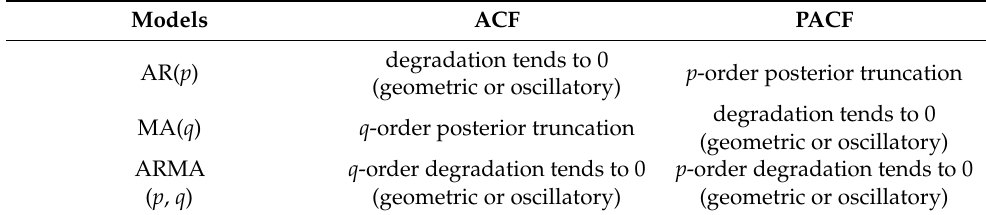
Table 1. Determination of the p and q order of the ARIMA model.